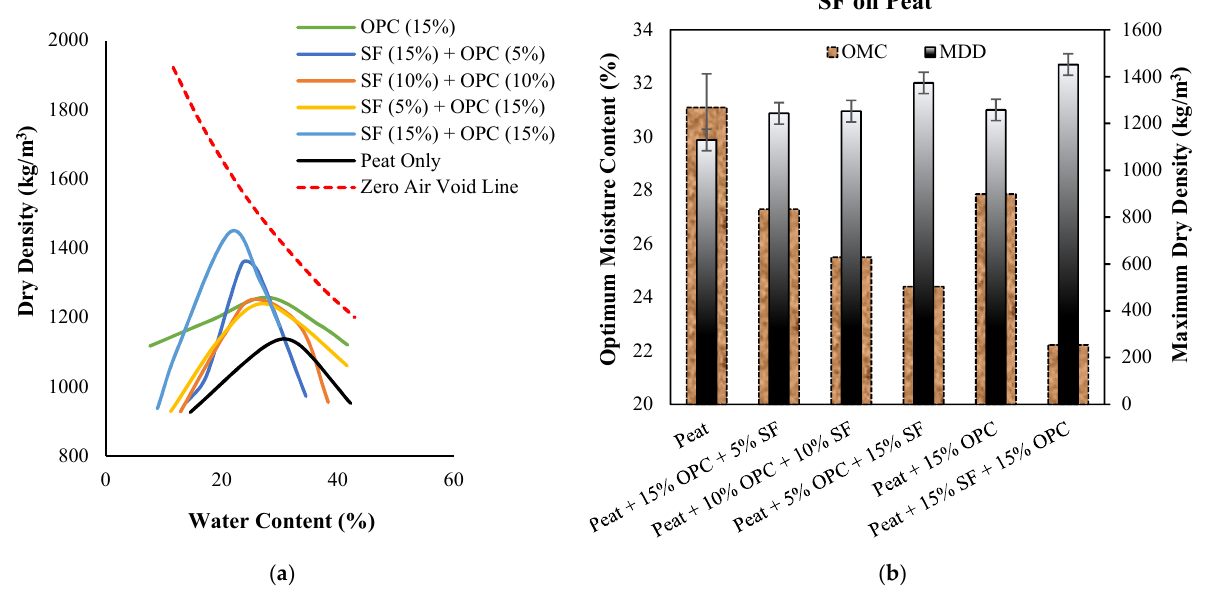
Figure 2. ( a ) Standard compaction curves of untreated and treated peat with varying percentages of SF and OPC; ( b ) effects of varying SF–OPC dosages on the dry density and W opt of treated peat.